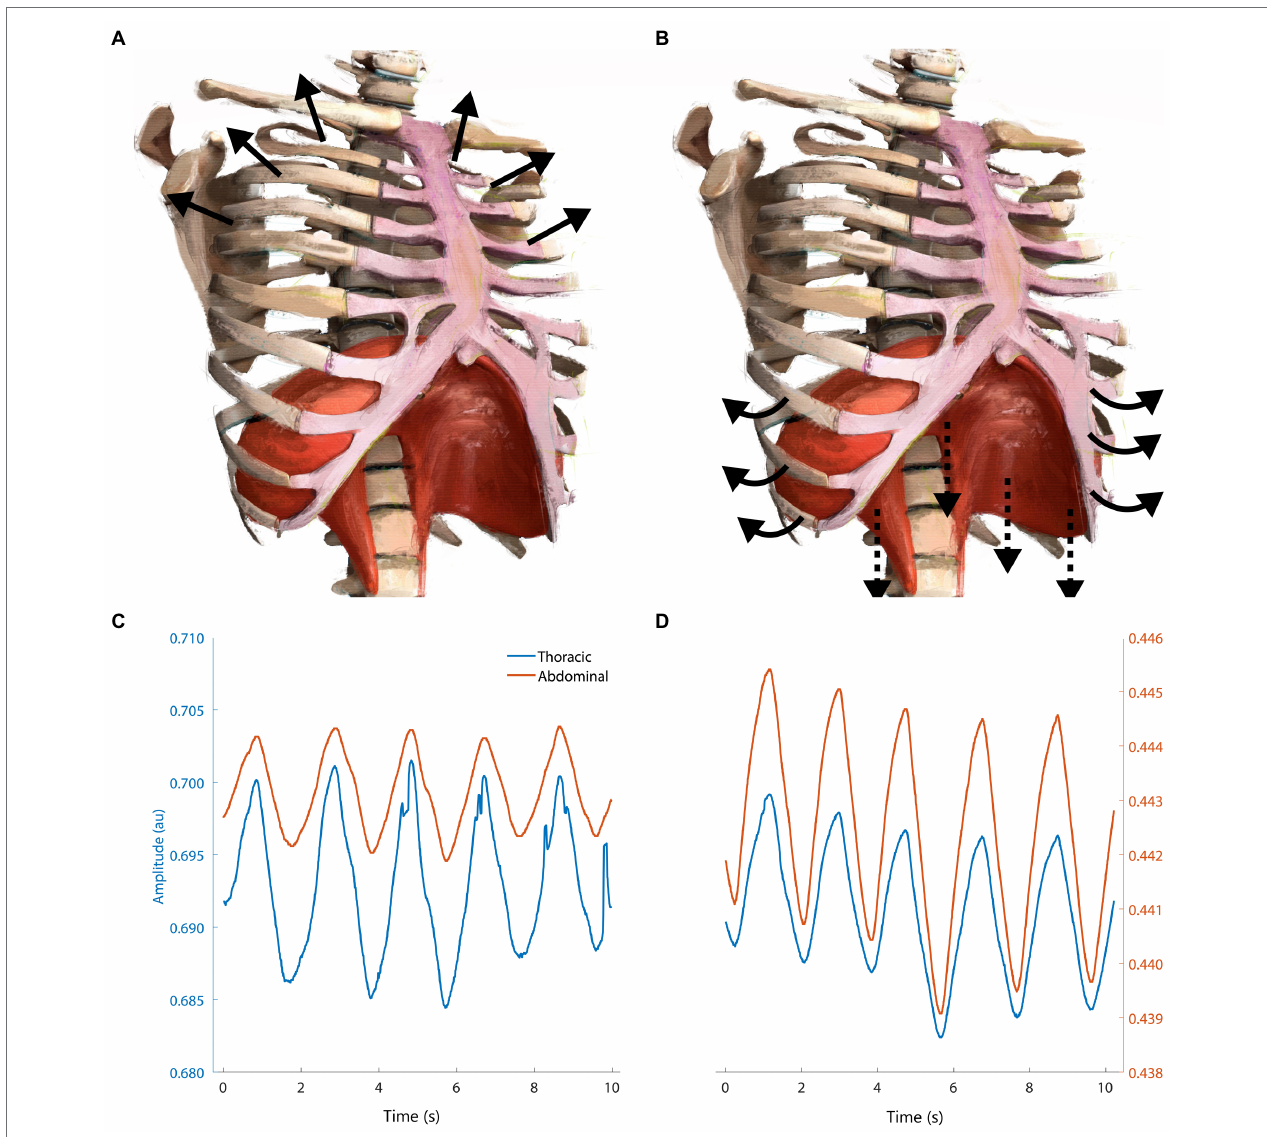
FIGURE 5 | Schematic showing the difference between upper-thoracic dominant breathing (A,C) vs. “deep” diaphragmatic breathing (B,D) . (A) Upper-thoracic breathing elevates and expands the upper ribcage, visible in (C) respiratory inductance plethysmography measurements from our lab showing increased amplitude in thoracic vs. abdominal bands. (B) Deep breathing flattens the diaphragm against the inferior abdominal viscera, expanding the abdominal ribcage via pump- and bucket-handle mechanisms. Adapted from Isometric angle of diaphragm and ribcage by Chest Heart & Stroke Scotland and Stuart Brett, The University of Edinburgh 2018 CC BY-NC-SA; arrows added for